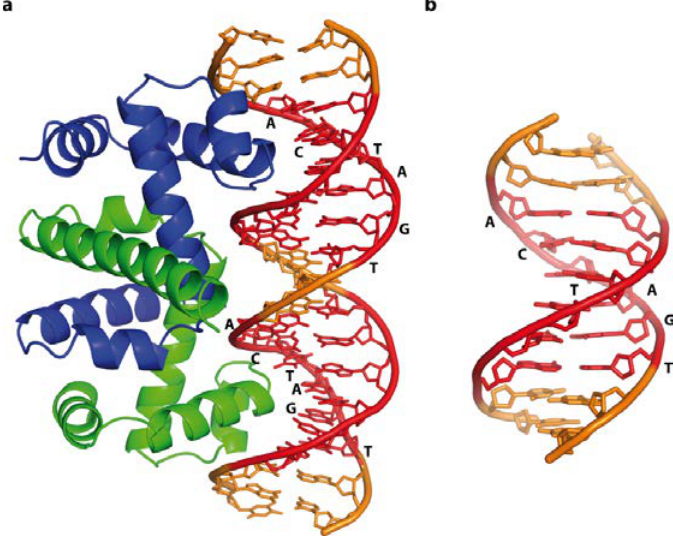
Figure 9. Free trp operator DNA, and in a complex with the Trp repressor protein, illustrating direct base readout and its impact on DNA structure. Cognate recognition sequences are highlighted in red. ( a ) Schematic representation of the trp operator-Trp repressor complex (PDB code 1TRO); The 15° bend compresses the major groove in the complex, whereas free DNA ( b ) (NDB code BDJ061) is straight, highlighting the subtle differences between bound and free